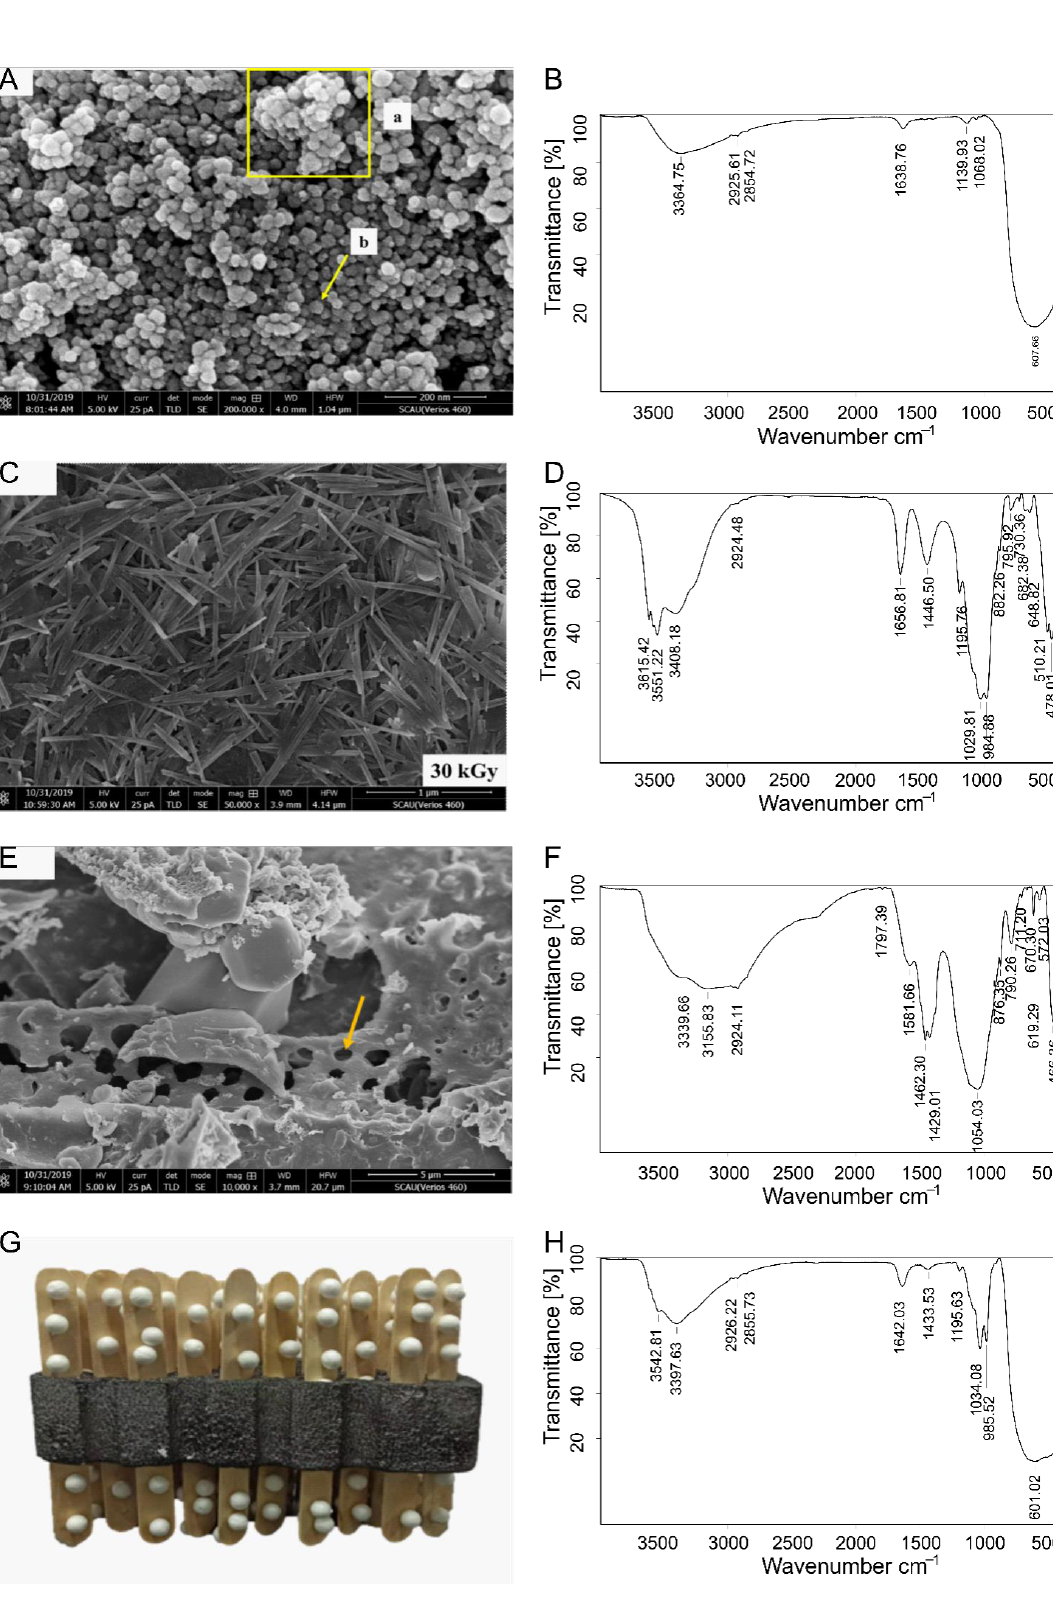
Figure 5. nTiO 2 composite reagent. ( A ): SEM image of P25 nTiO 2 : a: agglomeration, b: dispersion; ( B ): FTIR spectrum of nTiO 2 ; ( C ): 30 kGy radiation ATP SEM image; ( D ): FTIR spectrum of ATP; ( E ): BCS SEM image; Arrow indicates the microporous structure of BCS at 10,000 × magnification under SEM; ( F ): FTIR spectrum of BCS. ( G ): Ideal structure of composite reagent; ( H ): FTIR spectrum of nTiO 2 composite